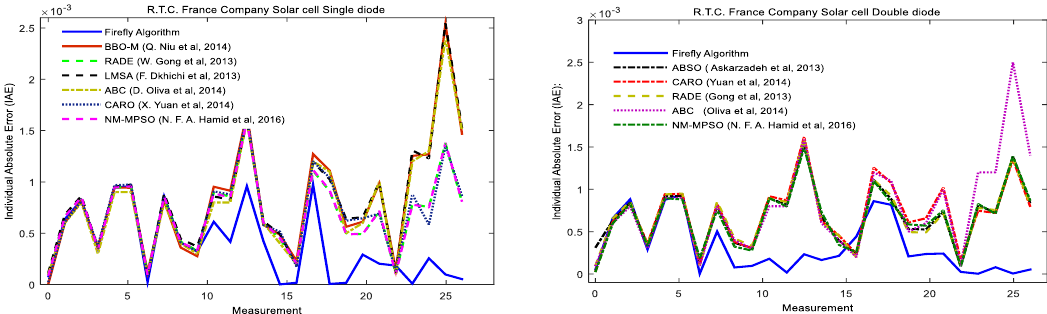
Figure 5. Individual absolute error (IAE) plots for single and double diode for Mono-crystalline silicon solar cell, RTC France Company.